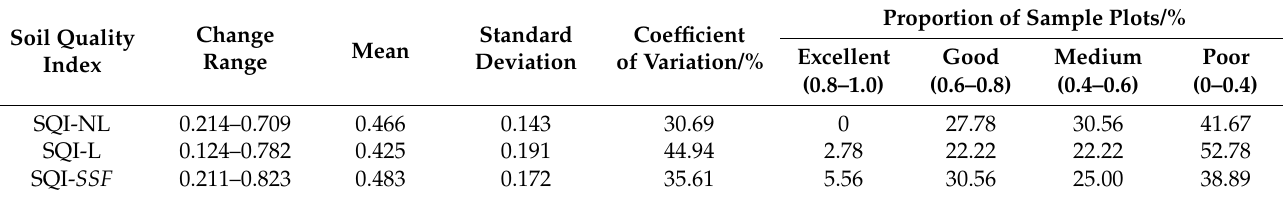
Table 5. Soil quality statistics in the minimum dataset